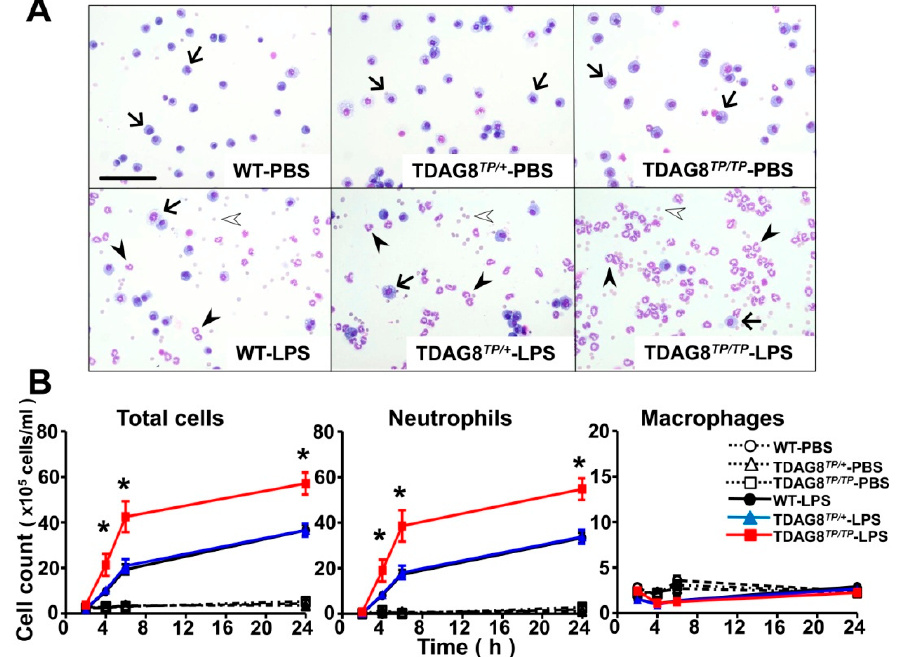
Figure 3. TDAG8 deficiency enhanced LPS-induced neutrophil accumulation. ( A ) Representative images of cells in BAL fluids 6 h after PBS or LPS treatment in WT, TDAG8 TP/+ and TDAG8 TP/TP mice. Arrows, arrowheads, and open arrowheads represent macrophages, neutrophils, and erythrocytes, respectively. Scale bar is 100 µm. One tenth volume of BAL fluids was used for LPS treatment as compared with those for PBS treatment; ( B ) Time course change in differential cell counts in BAL fluids. It is noted that, in addition to neutrophils, erythrocytes are also detected reflecting the damage of lung vasculature in BAL fluids from LPS-treated mice. However, erythrocytes were neglected for differential cell counts. Total cells, total white blood cells. Data are mean ± SEM of n = 5–15 for each group. The effect of TDAG8 deficiency is significant, * p < 0.05 ( TDAG8 TP / TP -LPS vs. WT-LPS or TDAG8 TP /+ -LPS).